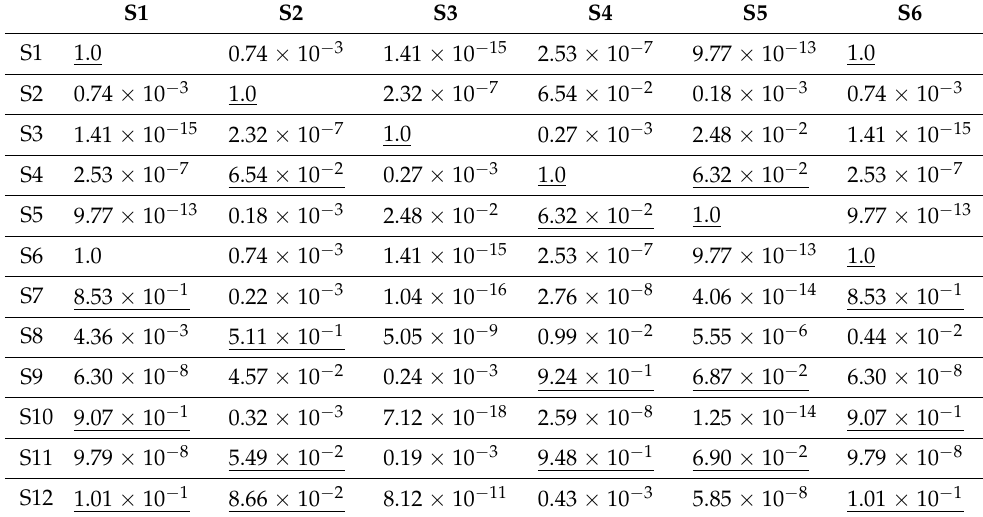
Table 10. t -test results for subjects 1–6.